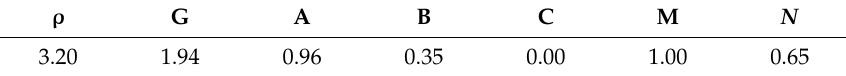
Table 1. Johnson–Holmquist 2 (JH2) constitutive model of SiC ceramic material.